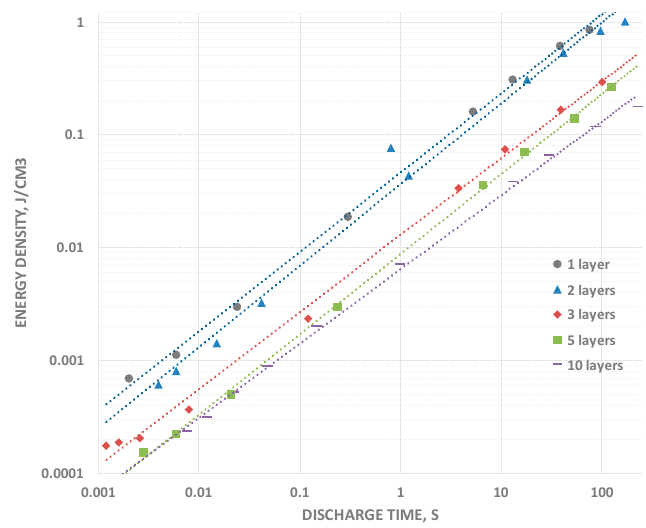
Figure 5. Energy Density vs. Discharge Time. The initial energy density at long discharge times is highest for one layer and decreases with each added layer, but the power law relationship (slope) between energy density and discharge time is very similar for all capacitors studied.